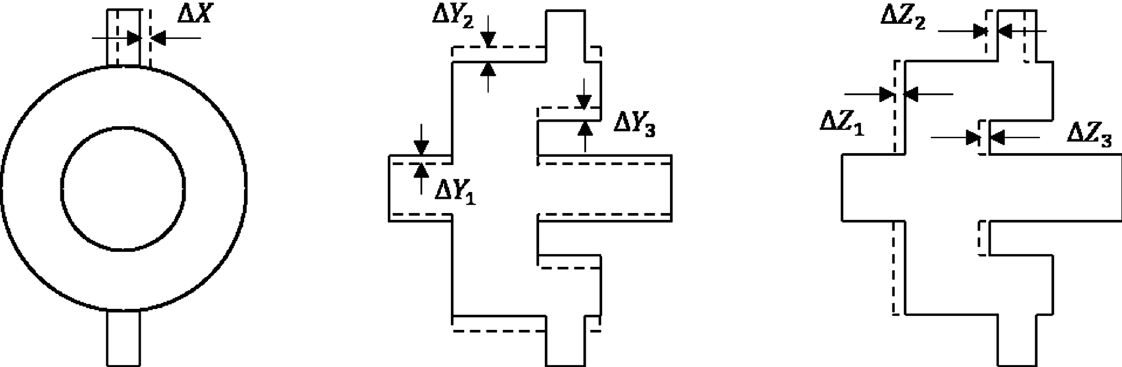
FIG. 4. Mechanical errors in three dimensions.